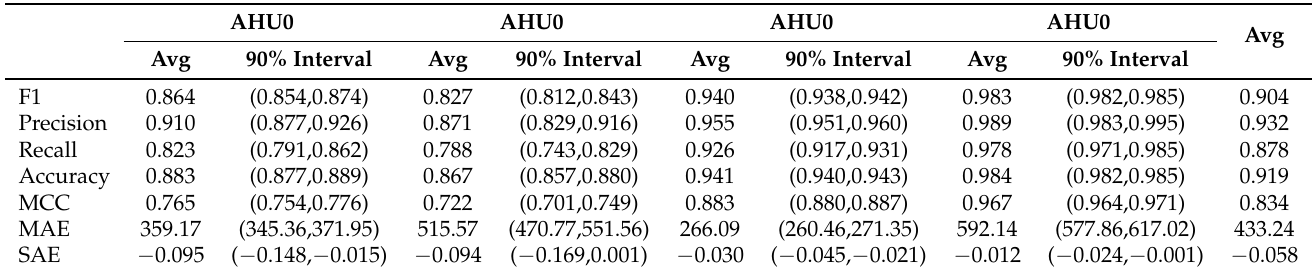
Table 7. Performance of the method in the unseen scenario, including the average and 90% interval of each load over twenty experiments and the average of all